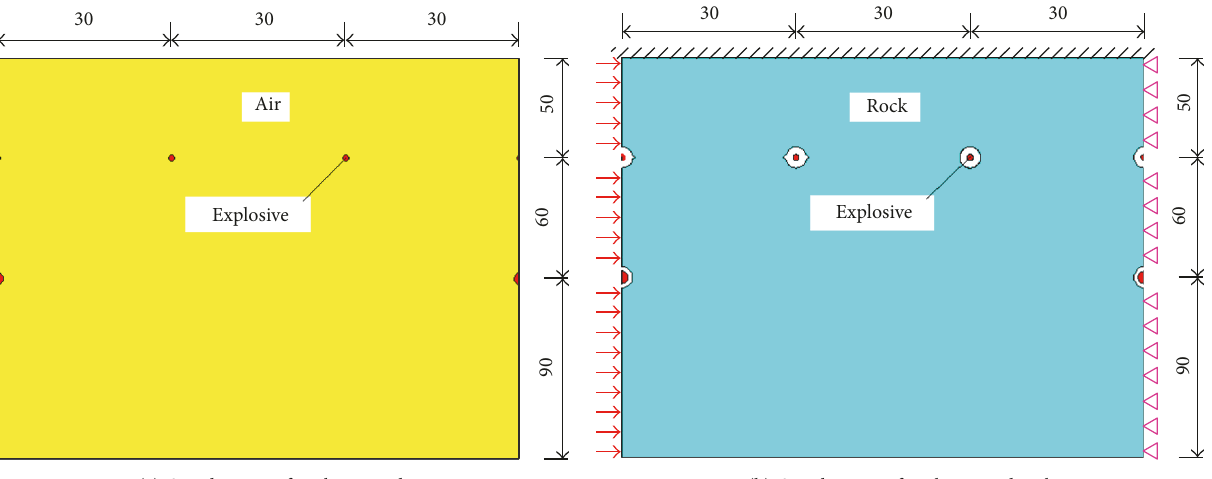
Figure 10: The calculation model of two-dimensional plane (unit: cm).